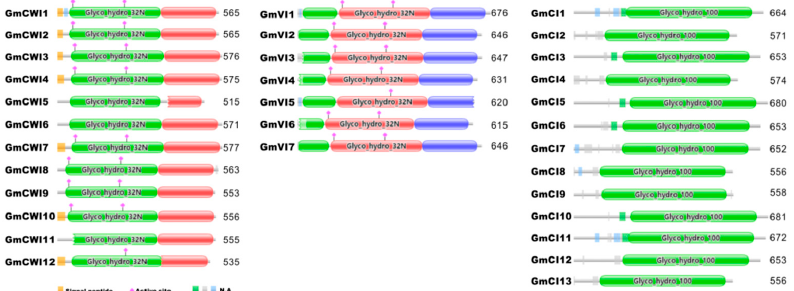
Figure 4. Deduction of conserved domains of the soybean invertase candidates. The diagram shows that cell wall invertase (CWI) and vacuolar invertase (VI) belong to glycoside hydrolase family 32 (GH32), whereas CI belongs to GH100. Numbers behind of each diagram indicate the number of amino acids. Predictions of the conserved domains were programed by using the PFAM (http://pfam.xfam.org/)